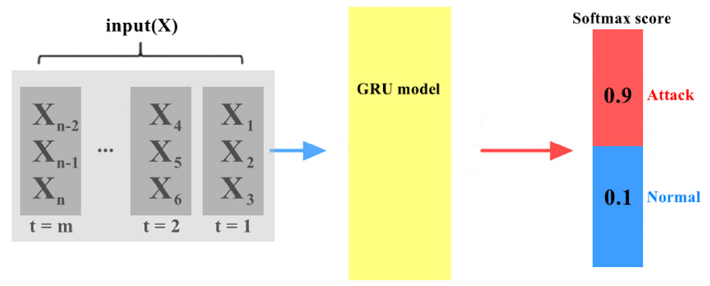
Figure 5. The Softmax score of output in the GRU mode.